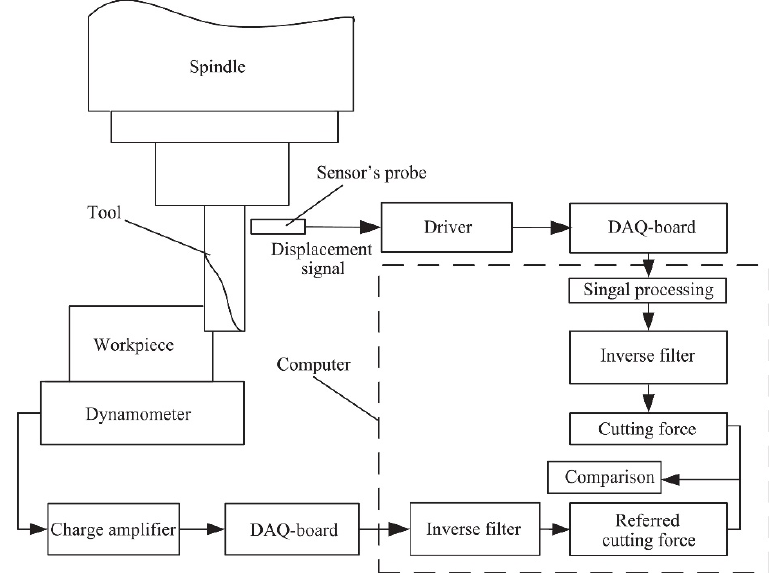
Figure 2. Experimental procedure for the measure and comparison of cutting forces during machining